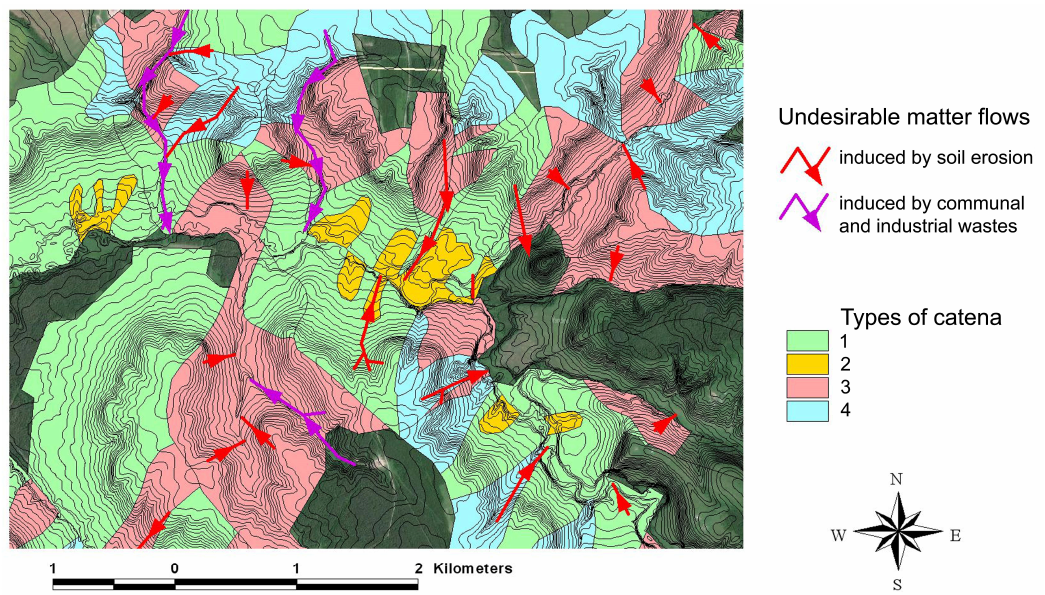
Figure 6. Pathways of undesirable matter flows and structure of catenas within the central part of the agrolandscape. Sequence of spatial elements in catenas: 1 ‐ Autonomous (interfluve) ‐ Trans ‐ eluvial (slope) ‐ Trans ‐ accumulative (deluvial train) ‐ Autonomous (terrace) ‐ Small gullies ‐ Super ‐ aqual (floodplain); 2 ‐ Autonomous (terrace) ‐ Super ‐ aqual; 3 ‐ Autonomous (interfluve) ‐ Trans ‐ eluvial ‐ Trans ‐ accumulative ‐ Super ‐ aqual; 4 ‐ Autonomous (interfluve) ‐ Trans ‐ eluvial ‐ Gullies ‐ Super ‐